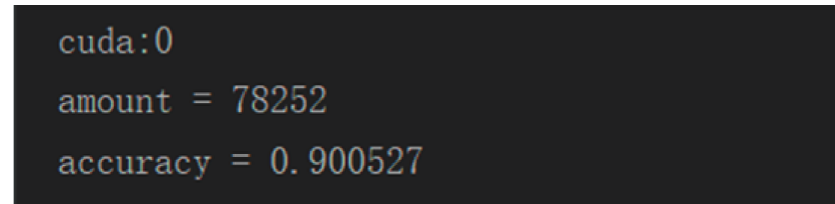
Figure 16: CCPD recognition